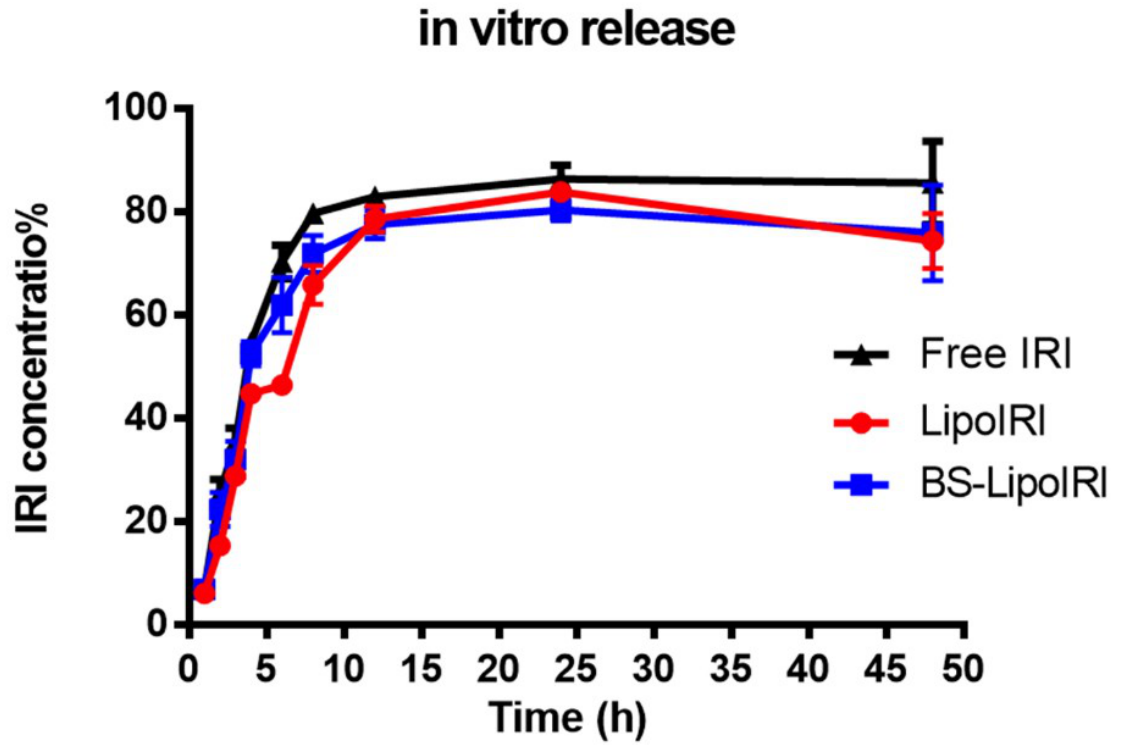
Pharmaceutics 2022 , 14 , x FOR PEER REVIEW Figure 3. Drug release profile of irinotecan of LipoIRI and BS − LipoIRI.